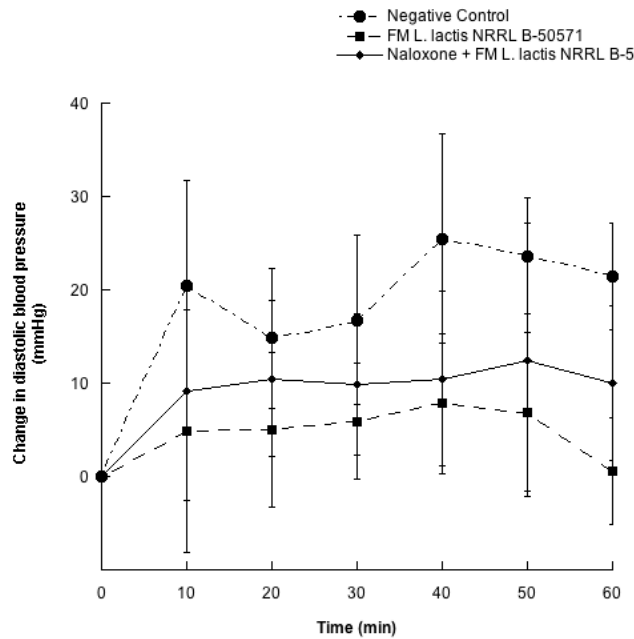
Figure 2. Change in diastolic blood pressure in spontaneously hypertensive rats with different treatments. Negative control: purified water; FM L. lactis NRRL B-50571: lyophilized water-soluble extract (35 mg protein/kg body weight) of fermented milk with L. lactis NRRL B-50571; Naloxone: (1 mg/kg body weight) Antagonist μ opioid receptor + FM L. lactis NRRL B-50571: lyophilized water-soluble extract (35 mg protein/kg body weight) of fermented milk with L. lactis NRRL B-50571. Data are presented as means ± SEM.